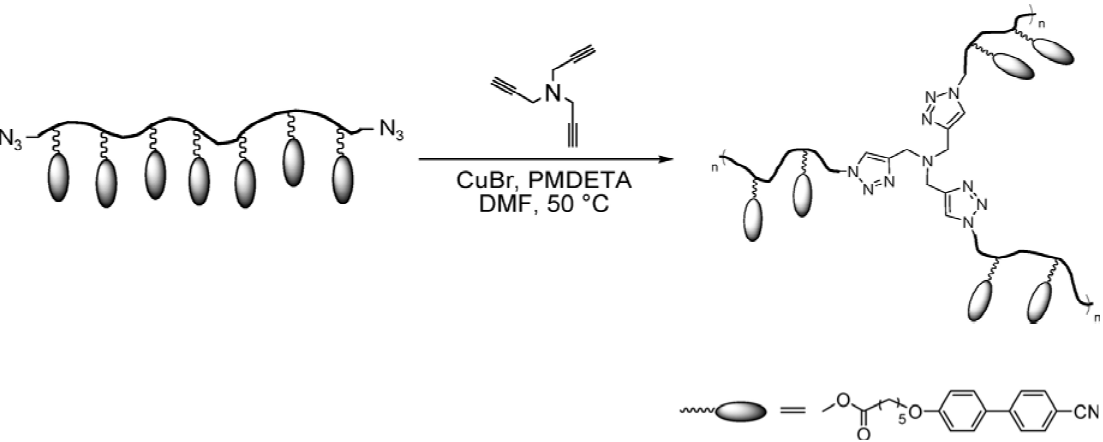
Figure 5. Crosslinking of telechelic polymer by reacting triacetylene species with azide functionalized LC polymer by “click chemistry”. Reprinted with permission from [36].